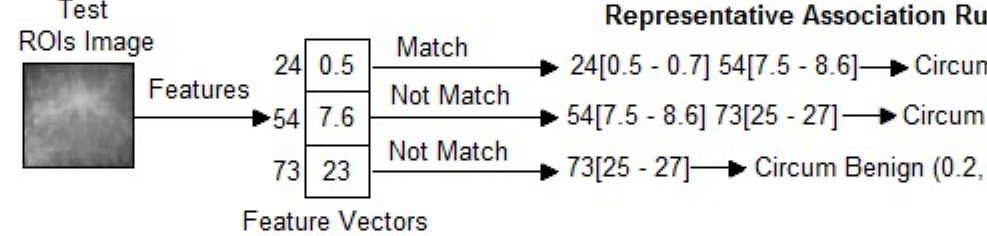
Figure 5. Example to show the calculation of Associative Medical Image Diagnosis Engine (AMIDE) in Condition